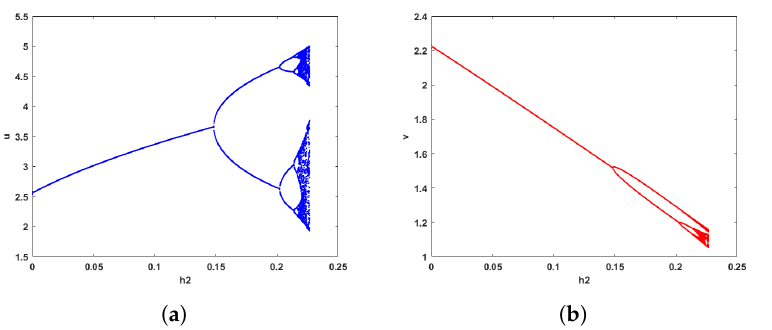
Figure 8. Bifurcation diagram of system (2) with h 2 ∈ [0, 0.25], r 1 = 0.8, r 2 = 0.8, a = 0.4, b = 0.2, c = 2, d = 0.1, k = 5, h 1 = 0, δ = 4.88, the initial value is ( u , v ) = (4, 2). ( a ) Bifurcation diagram for u